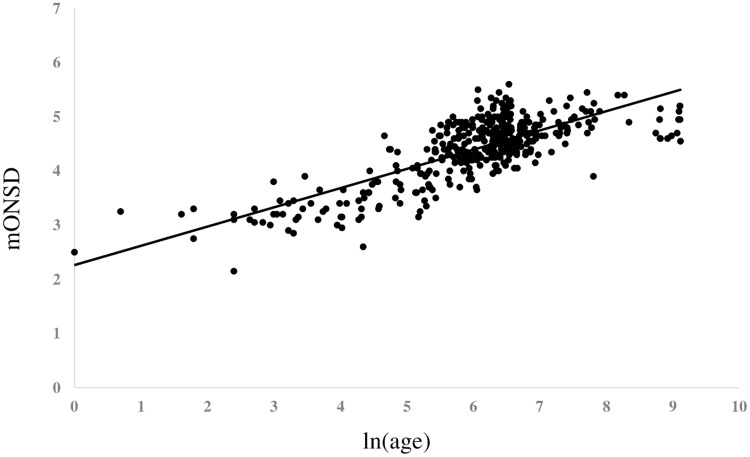
Optic nerve sheath diameter of those in normal control plotted in relation to ln(age).Results of regression analysis and Spearman’s rank correlation analysis is shown in separate table. mONSD; mean optic nerve diameter, ρ; Spearman’s rank correlation coefficient.